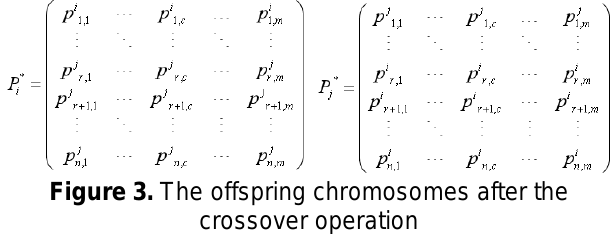
Figure 3. The offspring chromosomes after